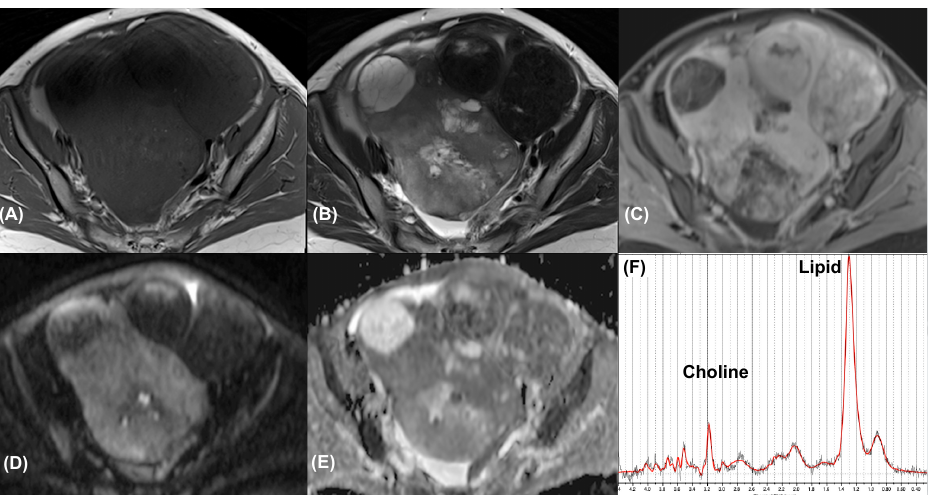
Figure 4. Clear cell carcinoma in a 33-year-old woman. Axial ( A ) T1-weighted, ( B ) T2-weighted, and ( C ) contrast-enhanced T1-weighted MR images show a cystic tumor in adnexa with irregular solid component ( arrow) exhibit marked contrast enhancement. Axial ( D ) high- b -value DW image ( b = 1000 s/mm 2 ) and ( E ) ADC map demonstrated marked restricted diffusion of the solid component. The tumor was classified as an O-RADS 5 lesion. ( F ) MR spectroscopy depicts choline and lipid peaks (SNR = 29.0 ± 1.8; linewidth = 4.7 ± 1.2 Hz). Data are in black, and the corresponding fit is in red.